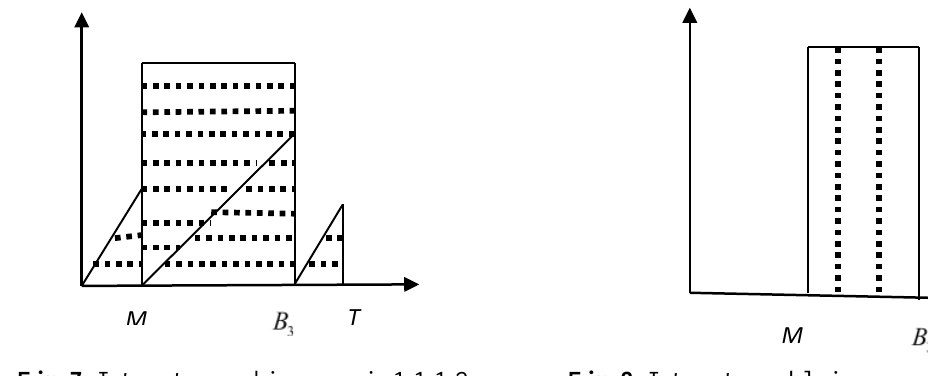
Fig. 7. Interest earned in scenario 1.1.1.2 Fig. 8. Interest payable in scenario